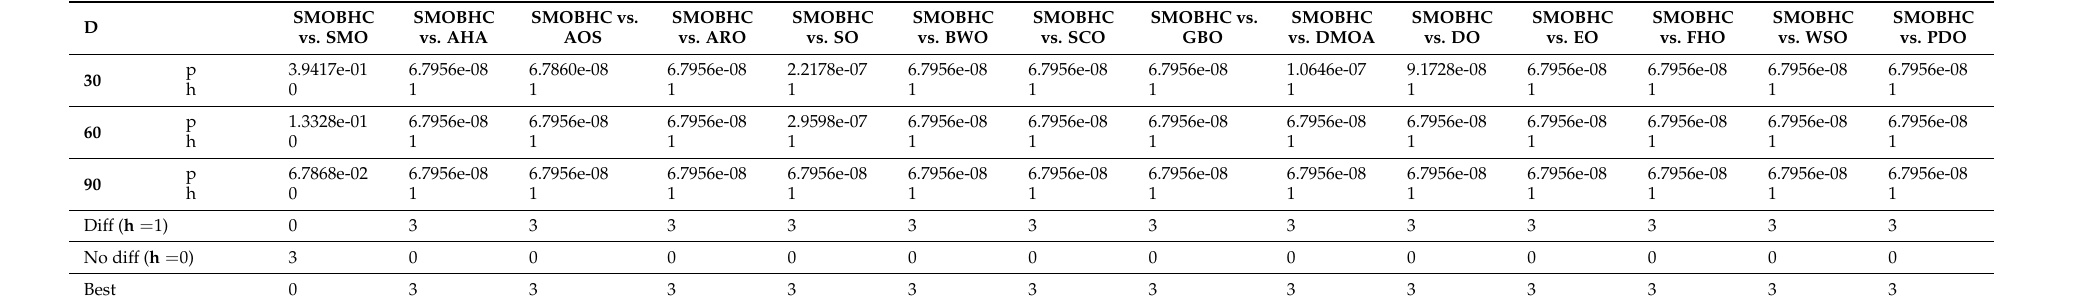
Table 8. Summarised Wilcoxon rank-sum comparisons between the SMOBHC algorithm as a reference and fourteen experimented algorithms for the third battlefield composed of twenty